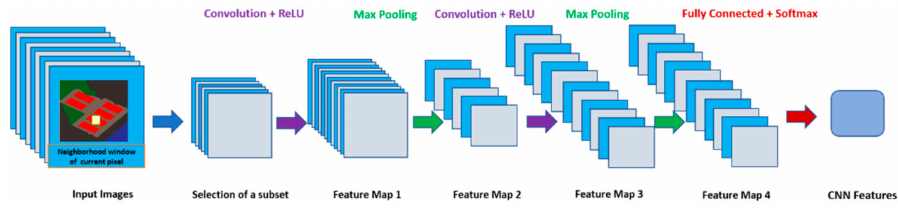
Figure 4. CNN feature extraction using pretrained